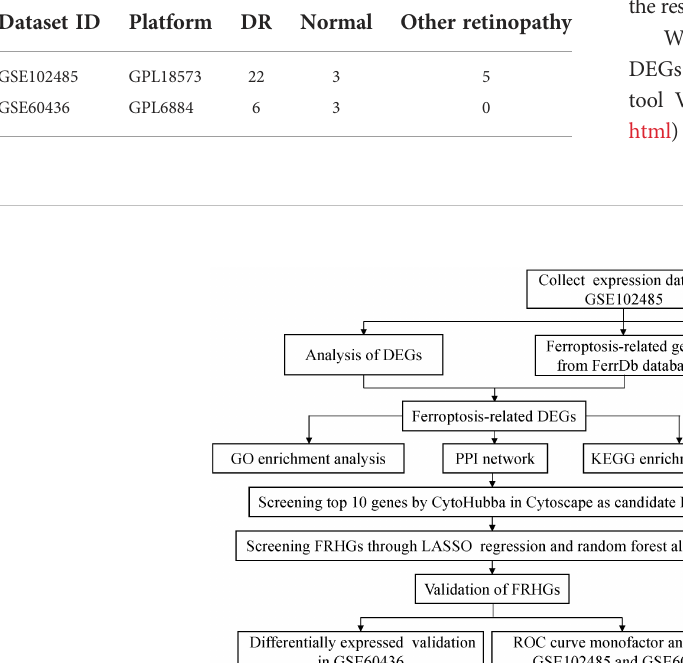
TABLE 1 Diabetic retinopathy (DR) datasets from the GEO database.